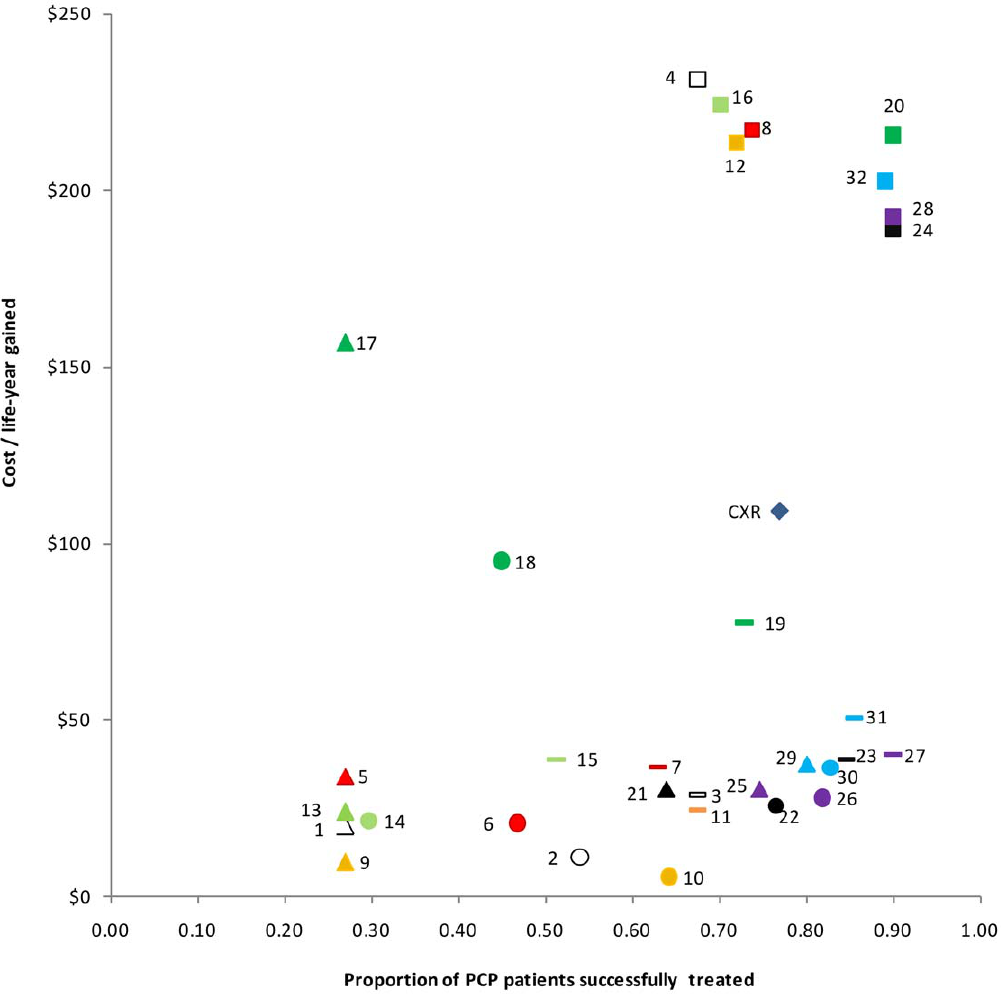
Figure 2. Scatterplot showing total costs for diagnostic procedures and treatment, per life-year gained, at 50% prevalence among population tested. Triangles represent procedures involving oral washes; circles represent procedures involving expectorated sputum; lines represent procedures involving induced sputum; and squares represent procedures involving BAL. All white data points outlined in black indicate procedures using the Diff-Quick test (1–4); red indicates procedures using GMS (5–8); orange indicates procedures using TBO (9–12); light green indicates procedures using calcofluor white (13–16); dark green indicates procedures using IFA (17–20); black indicates procedures using PCR (21–24); purple indicates procedures using nPCR (25–28); and blue indicates procedures using rtPCR (29–32). Figure 2 Legend: 1: DQ/OW; 2: DQ/ES; 3: DQ/IS; 4: DQ/BAL; 5: GMS/OW; 6: GMS/ES; 7: GMS/IS; 8: GMS/BAL; 9: TBO/OW; 10: TBO/ES; 11: TBO/IS; 12: TBO/BAL; 13: CW/OW; 14: CW/ES; 15: CW/IS; 16: CW/ BAL; 17: IFA/OW; 18: IFA/ES; 19: IFA/IS; 20: IFA/BAL; 21: PCR/OW; 22: PCR/ES; 23: PCR/IS; 24: PCR/BAL; 25: nPCR/OW; 26: nPCR/ES; 27: nPCR/IS; 28: